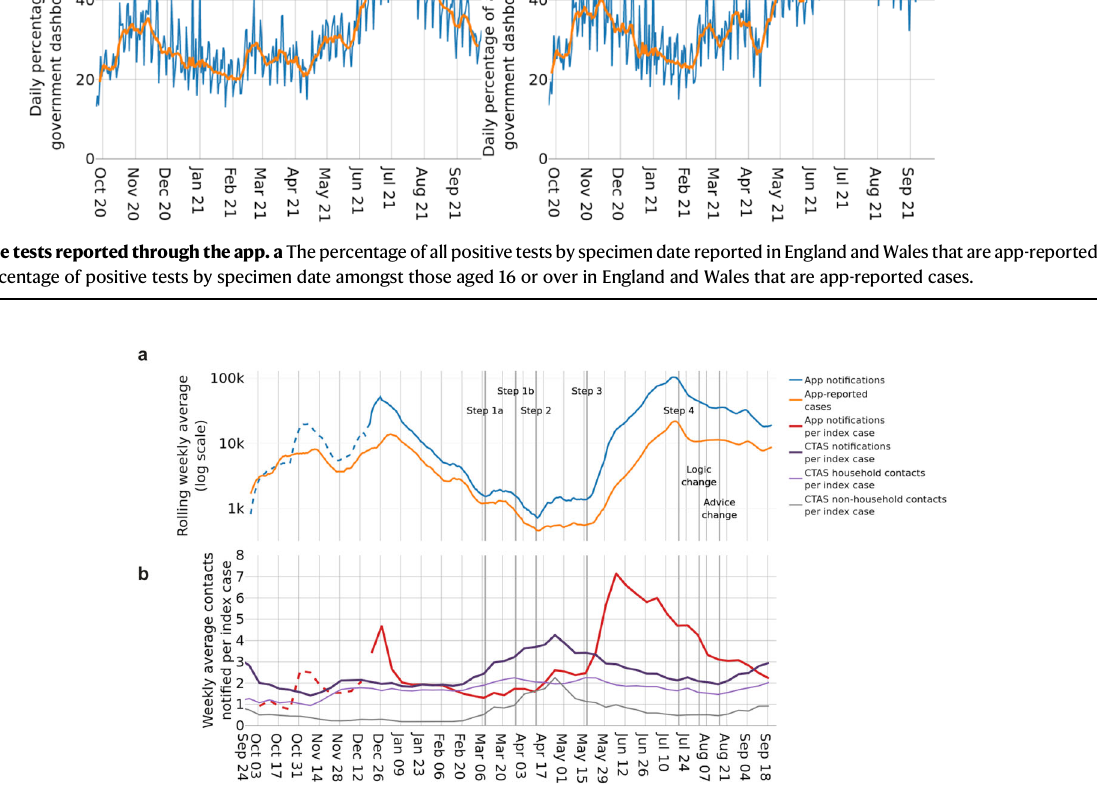
contacts traced via the app, CTAS, or both, is unknown. Dotted lines represent estimated values. Annotations refer to: the steps of a ‘ roadmap out of lockdown ’ 16 ; a change to the contact tracing logic of the app for the contacts of asymptomatic cases, and a policy change where some (mainly vaccinated) users were advised to take a PCR test rather than self-isolate upon noti fi cation. These events are descri- bed in more detail in a timeline in the Supplementary